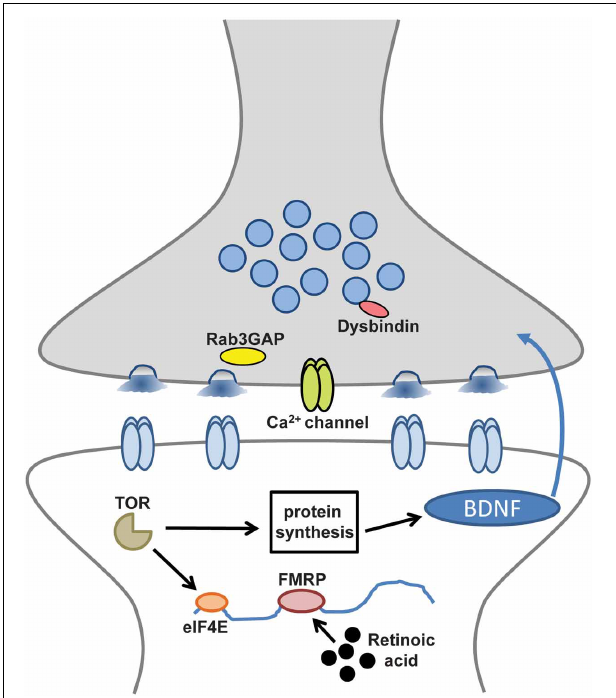
FIGURE 1 | Disease-related molecules and pathways required for retrograde and presynaptic homeostatic signaling. Synaptic components and processes involved in retrograde signaling and presynaptic homeostatic plasticity that may also contribute to neurological and neuropsychiatric